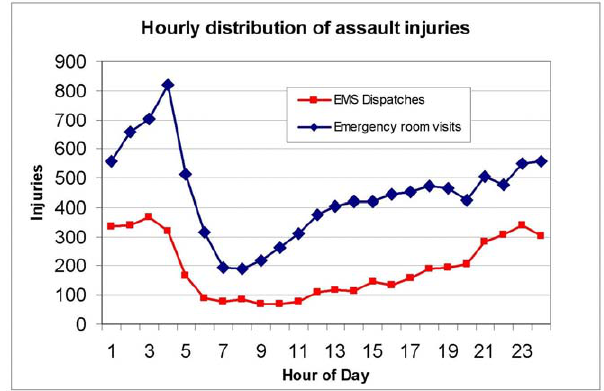
Figure 1. Hourly distribution of assault injuries in Toronto.